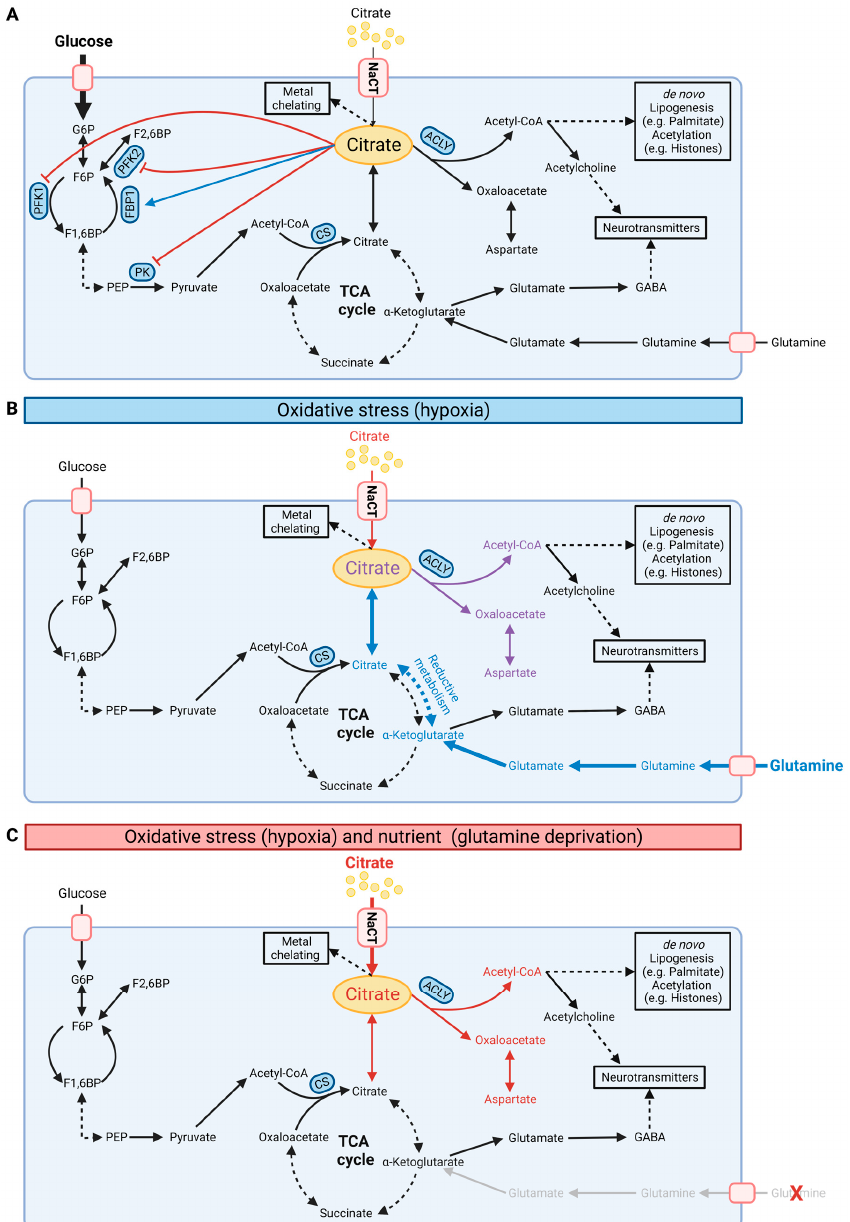
Figure 3. Schematic illustration of cellular citrate homeostasis. ( A ) Citrate is involved in multiple biochemical pathways under normoxic conditions. Cytosolic citrate inhibits glycolysis via PFK1, PFK2, and PK while stimulating FBP1 in gluconeogenesis. Cytosolic citrate is cleaved by ACLY to oxaloacetate and acetyl-CoA, thus influencing de novo lipogenesis, protein acetylation, and synthesis of neurotransmitters. ( B ) Under oxidative stress such as hypoxia conditions, cells reprogram citrate metabolism and increase reductive carboxylation metabolism for de novo lipogenesis. ( C ) NaCT facilitates citrate transport and metabolism under glutamine deprivation and oxidative stress. G6P: glucose-6-phosphate; F6P: fructose-6-phosphate; F1,6BP: fructose-1,6-bisphosphate; PEP: phospho- enolpyruvate; PFK: phosphofructokinase; PK: pyruvate kinase; FBP1: fructose 1,6-bisphosphatase; ACLY: ATP-citrate lyase; CS: citrate synthase; NaCT: sodium-coupled citrate transporter. Black, red, and blue fonts distinguish the carbon sources glucose, citrate, and glutamine, respectively. In ( B ), purple font indicates the combined carbon sources citrate and glutamine. Bold fonts and bold arrows indicate increasing fluxes. In ( A ), the blue arrow indicates stimulation and the red arrows inhibition. (Created with